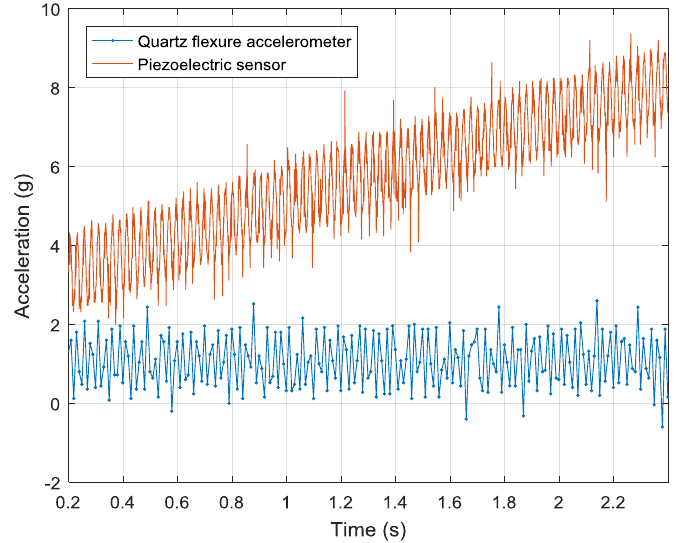
Figure 9. Experiment of the dual-sensor vibration measuring system.